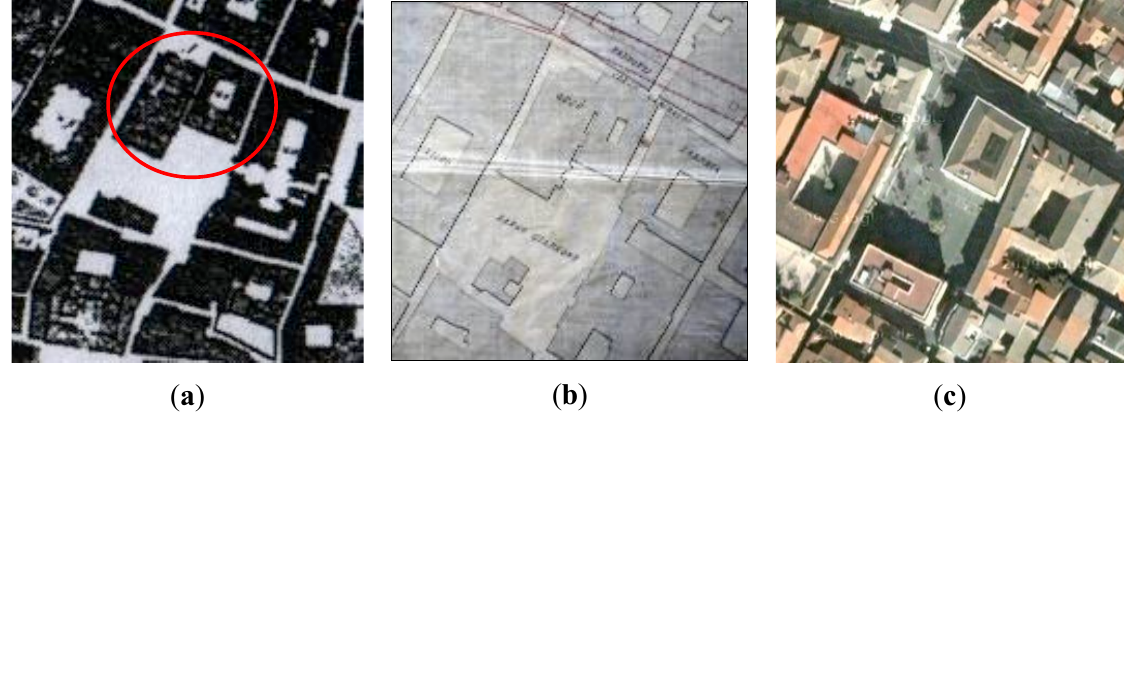
Figure 1. ( a ) Map of Benevento at the end of XVIII century; ( b ) regulator plan of Benevento in 1880; ( c ) aerial view of historical center of Benevento near Palazzo Bosco Lucarelli in 2012 from a satellite